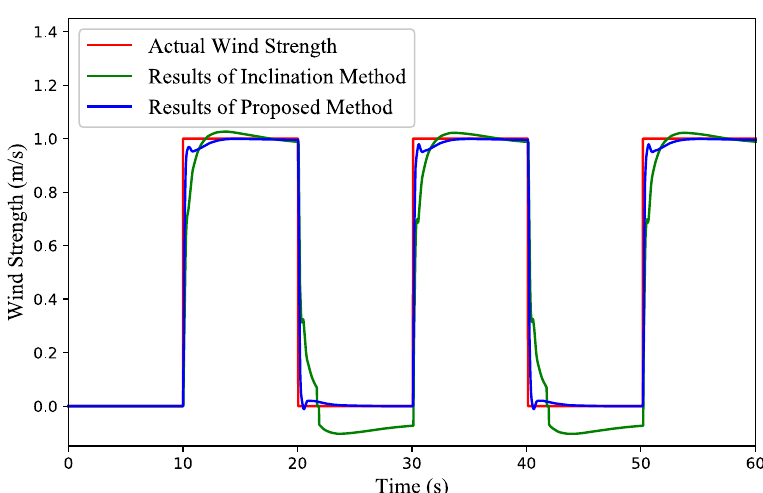
Figure 8. Simulation results of the gust wind estimation with a quadrotor in hovering condition.